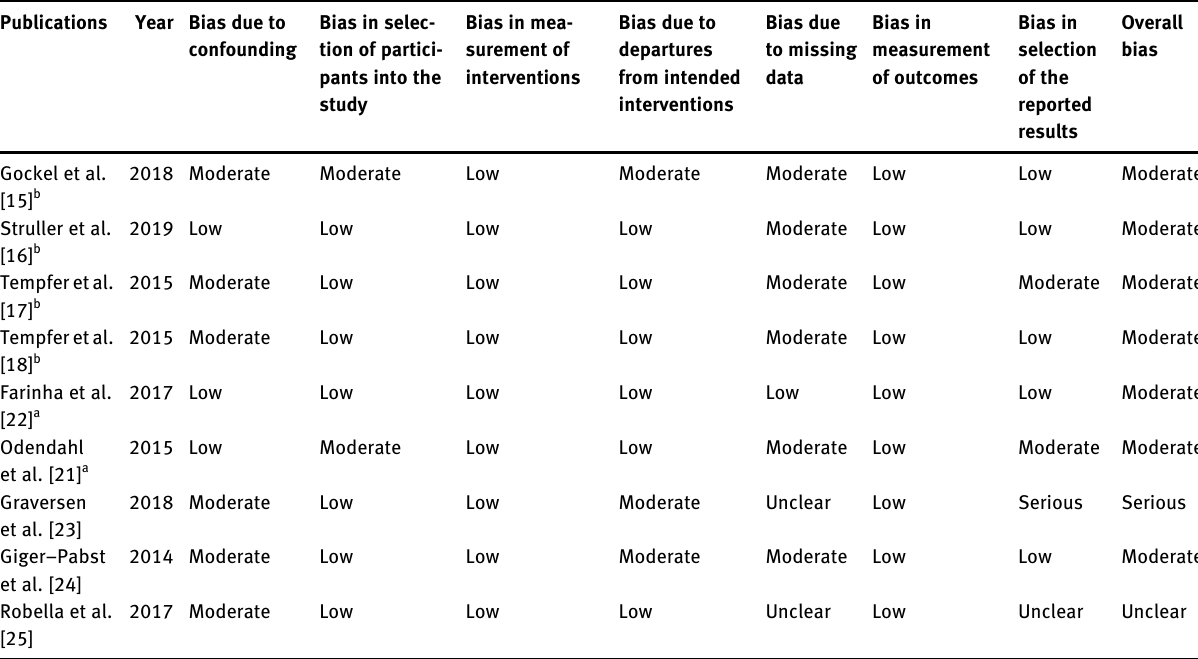
Table  : Risk of bias (RoB) using ACROBAT-NRSI tool [  ]. Overall RoB for each study is considered (  ) low if the study is judged to be at low RoBforalldomains,(  )moderateifthehighestriskamongalldomainsismoderate(  )seriousifthehighestriskamongalldomainsisserious, or (  ) critical if the highest risk among all domains is critical [  ].